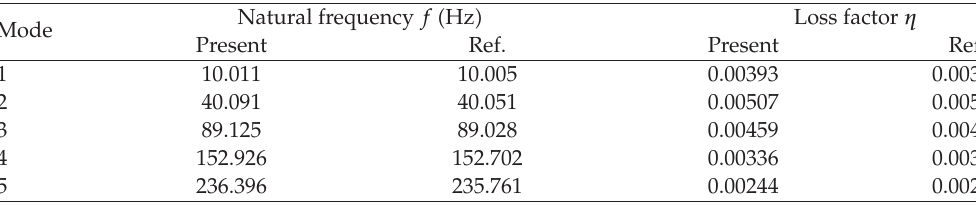
Table 1: Comparison of natural frequencies and loss factors obtained herein with those of (cid:5) 19 (cid:6) (cid:2) L (cid:8)